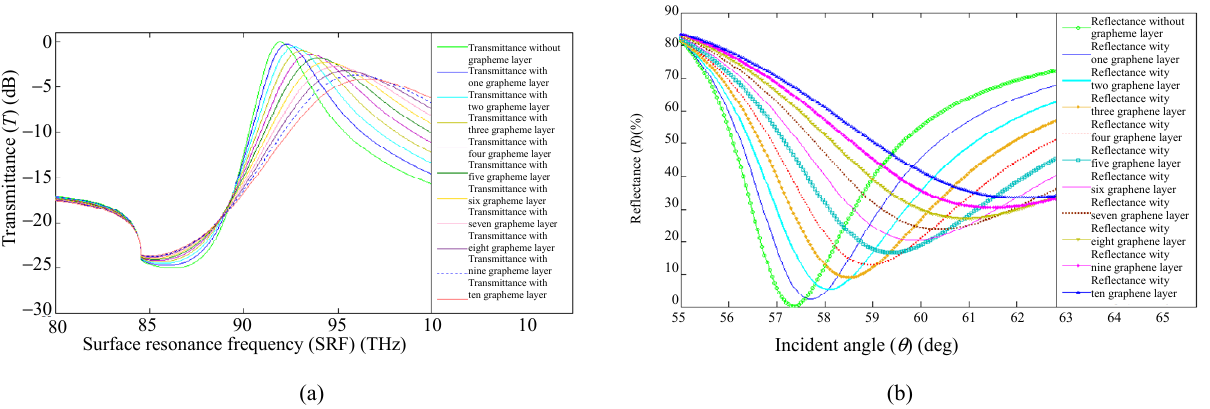
Fig. 4 Change in characteristics curves for (a) SPR curves and (b) SPRF curves for the fiber optic SPR biosensor without graphene and with graphene implicated sensor (for £ = 1, 2, 3, … , 10) before the adsorption of target BRCA DNA molecules. Table 3 Data of R min , θ SPR , T max , and SRF without graphene layer and with the total number of increasing graphene layer in fiber optic SPR